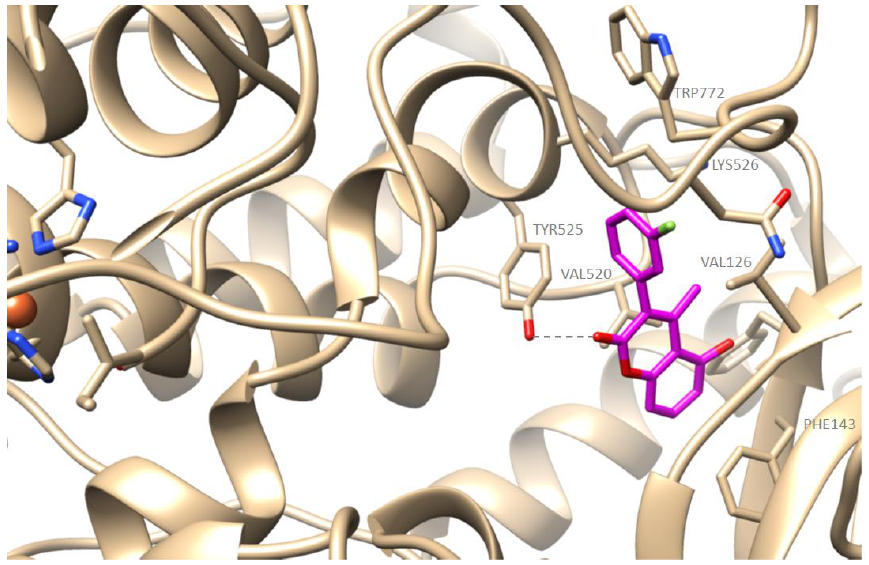
Figure 1. Preferred docking pose of 4e (depicted in magenta) bound to soybean lipoxygenase (LOX-1).